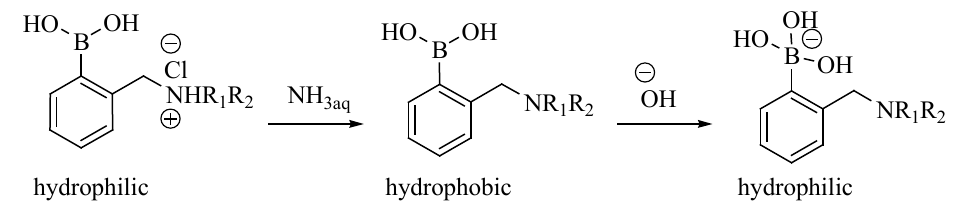
Scheme 3. Various forms of 3 depending on pH.